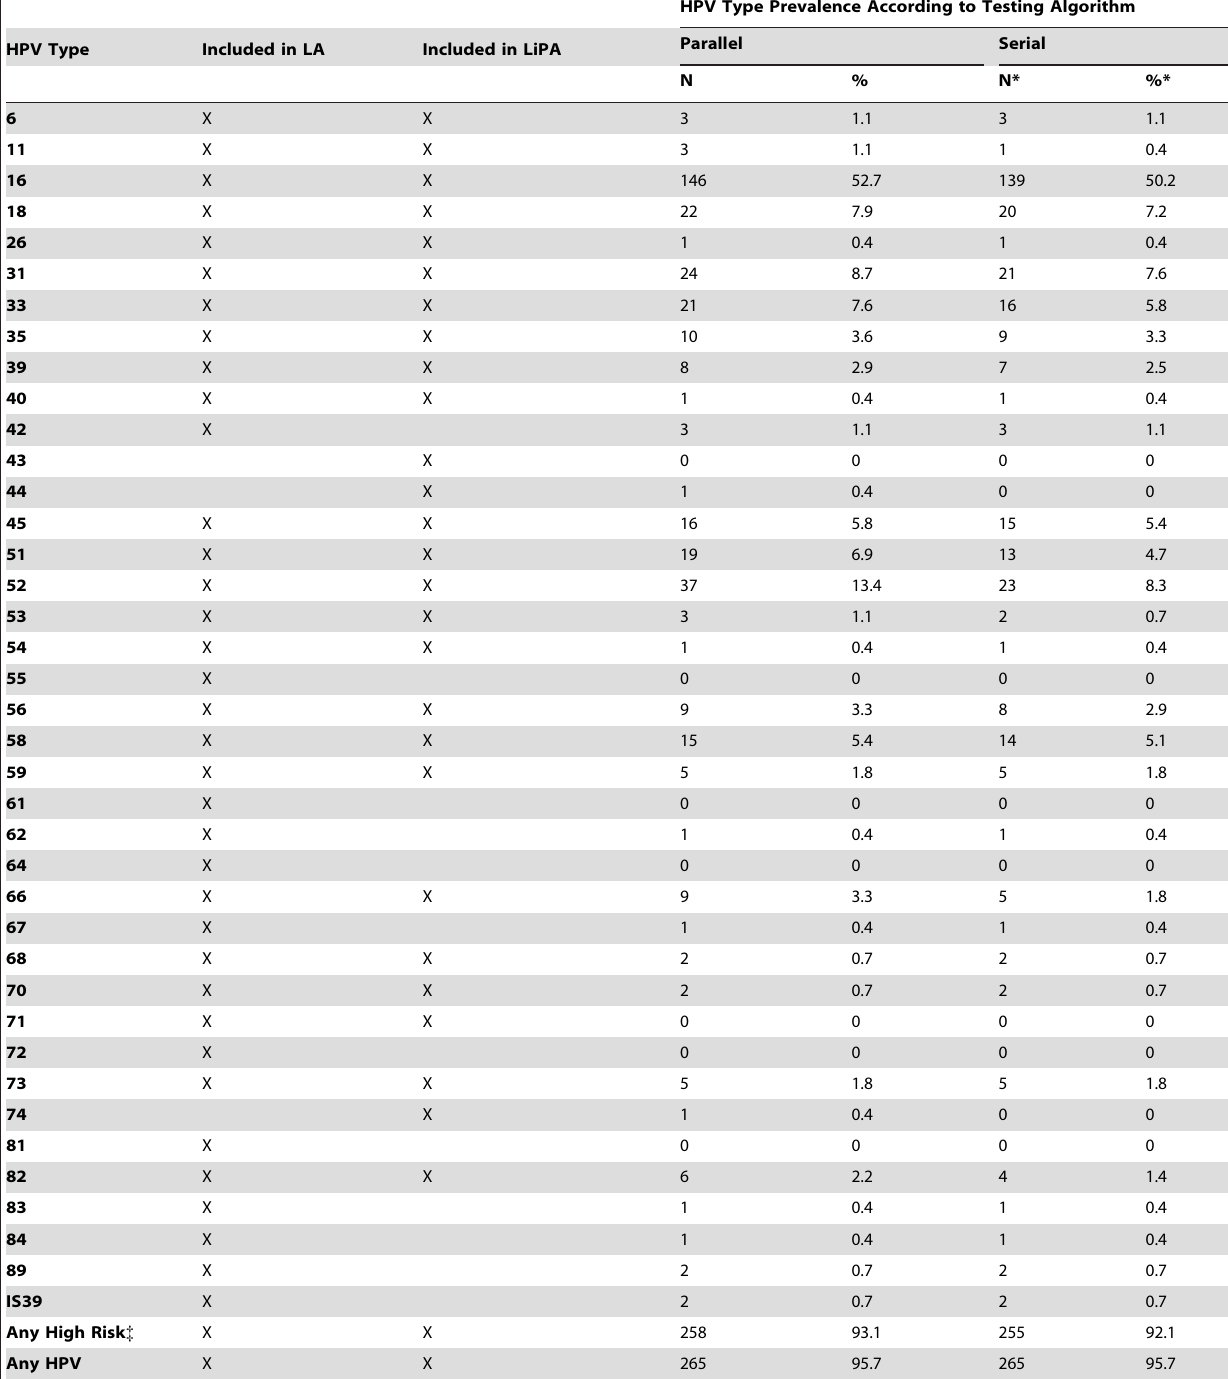
HPV Type Prevalence According to Testing Algorithm